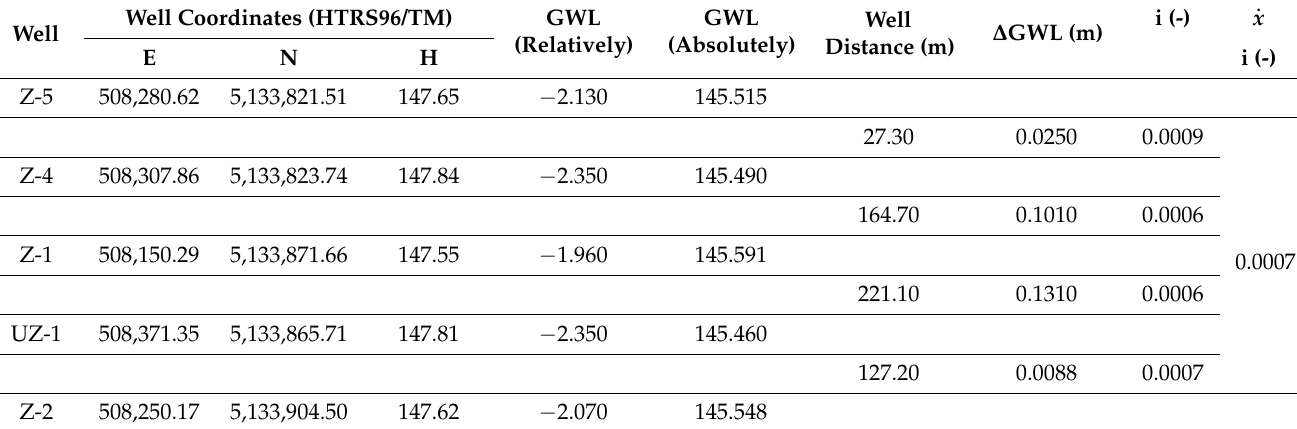
Table 2. Determination of Darcy’s and actual groundwater flow rate.